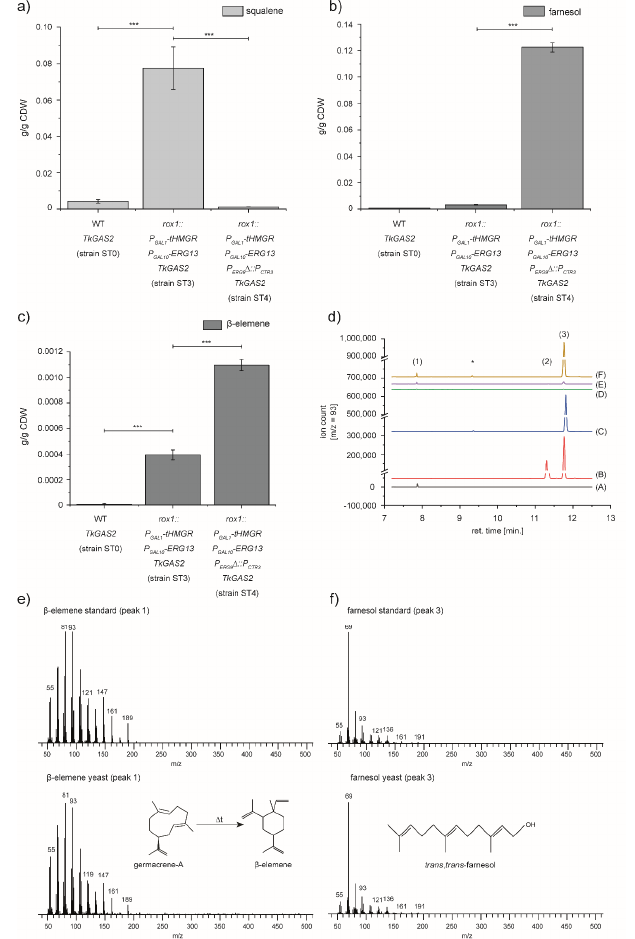
Figure 2. Germacrene-A and farnesol synthesis in S. cerevisiae expressing TkGAS2 . ( a ) Squalene accumulation in yeast strains expressing TkGAS2 . Yeast strain ST3 carrying the TkGAS2 coding sequence in addition to the HMGR and ERG13 overexpression cassette ( rox1::P GAL1 -tHMGR P GAL10 -ERG13 TkGAS2 ) showed a significantly increase in squalene accumulation compared to the wild type yeast expressing TkGAS2 (strain ST0). This accumulation diminishes upon introduction of the CTR3 promoter prior to the ERG9 coding sequence (strain 4) and in the growth of CuSO 4 containing media. ( b ) Enhanced trans-trans- farnesol accumulation upon ERG9 repression. trans-trans- farnesol starts to accumulate significantly upon repression of ERG9 (strain 4). ( c ) Germacrene-A is converted into β -elemene, caused by the high temperatures during GC-MS analysis [27,28] and accumulates continuously in the engineered yeast strains ST3 and ST4. ( d ) Yeast strains carrying the TkGAS2 coding sequence ((D) = WT TkGAS2 (strain ST0); (E) = rox1::P GAL1 -tHMGR P GAL10 -ERG13 TkGAS2 (strain ST3); (F) = rox1::P GAL1 -tHMGR P GAL10 -ERG13 P ERG9 ∆ ::P CTR3 TkGAS2 (strain ST4)) showed an additional peak in the GC-MS spectrum (m / z = 93; peak (1)) compared to the control strain ((C) = rox1 :: P ∆ ::P GAL1 -tHMGR P GAL10 -ERG13 P ERG9 CTR3 (strain ST2)). The peak most likely represents β -elemene (ret. time = 7.9 min) as it matched to the corresponding standard ((A)). The significantly enhanced peak that most likely represents trans-trans- farnesol (peak (3); ret. time = 11.855 min) could be identified in the n-dodecane layer of yeast cultures upon ERG9 repression, as well as in the corresponding standard (B). peak (1) = β -elemene; peak (2) = cis - trans -farnesol and cis - cis -farnesol; peak (3) = trans - trans -farnesol; asterisk = unidentified yeast metabolite. ( e ) Mass spectra of the β -elemene standard and the designated β -elemene from yeast cultures, formed upon thermal conversion of germacrene-A in the analytic process. ( f ) Mass spectra of the trans - trans -farnesol standard peak and the designated trans-trans- farnesol peak produced by yeast cultures. n = 3 individual transformants; CDW, cell dry weight; *** p ≤